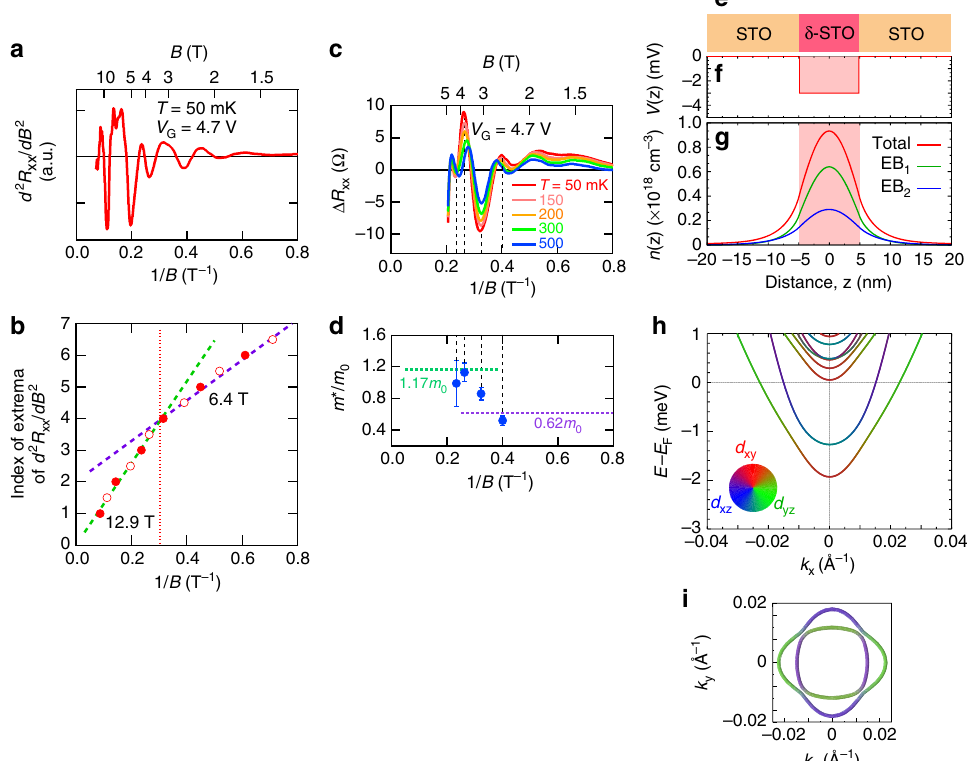
Figure 4 | Electronic structures of d -doped SrTiO 3 . ( a ) d 2 R xx / dB 2 as a function of 1/ B at 50mK with V G ¼ 4.7V, corresponding to n ¼ 1.0 (cid:3) 10 12 cm (cid:2) 2 . ( b ) Indices of extrema in d 2 R xx / dB 2 as a function of 1/ B . The integer (half integer) indices are assigned to the valley (peak) positions of R xx denoted by the closed (open) circles. The slope changes from 12.9 to 6.4T around 1/ B ¼ 0.3T (cid:2) 1 ( B ¼ 3.3T) as denoted by the dotted line. ( c ) SdH oscillations with V G ¼ 4.7V after subtracting the non-oscillating background, D R xx , is plotted as a function of 1/ B at various temperatures. ( d ) Effective mass m * experimentally determined from the temperature dependence of oscillation amplitude at each D R xx extremum is shown by closed circles and those theoretically derived are indicated by horizontal dotted lines. ( e – i ) The calculated band structure of d -doped STO-QW. The d -doped region is assumed to be sandwiched between two sufficiently large slabs of undoped STO as shown in e . Assuming a square potential for the QW ( f ), the total and subband- decomposed charge-carrier density distributions (denoted by EB 1 for outer FS and EB 2 for inner one) are plotted in g and h . The corresponding orbital- projected band structure of QW. ( i ) The Fermi surface formed by the confined